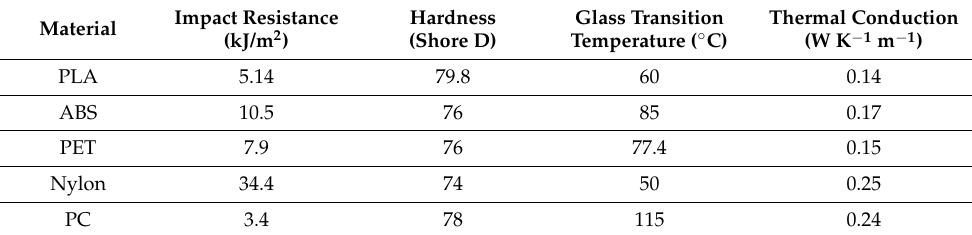
Table 4. Comparison among different printing materials.